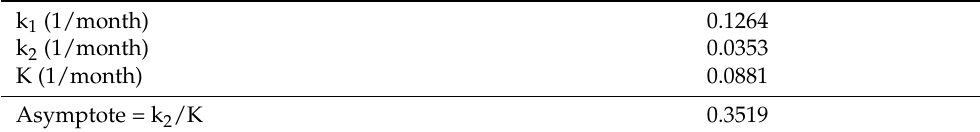
Table 2. Numerical solution of used model.